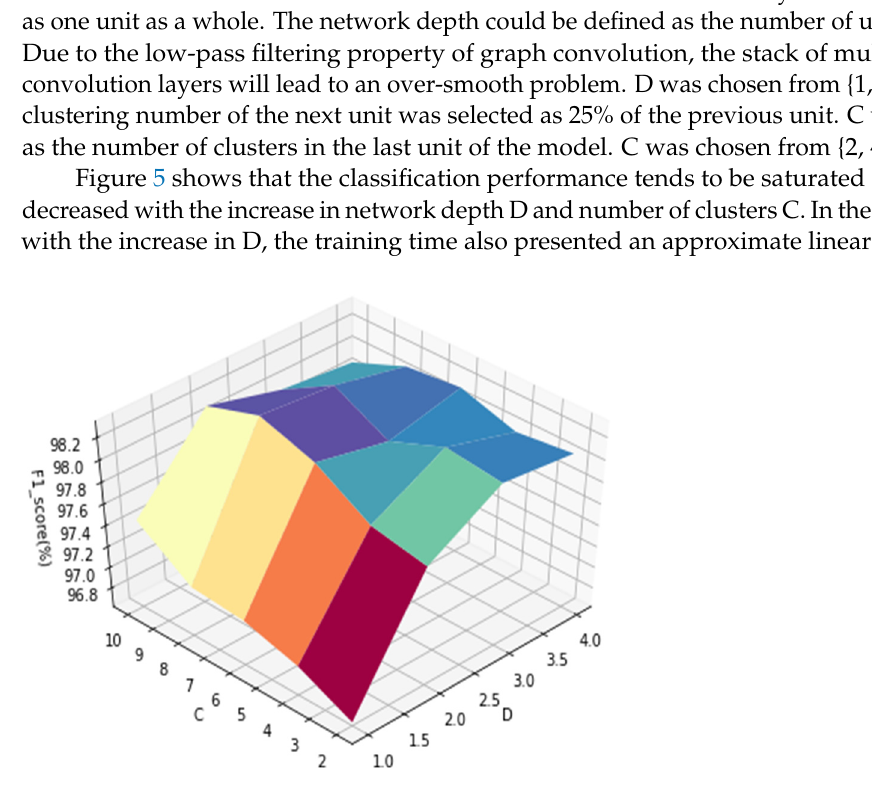
Figure 5. Performance with different model